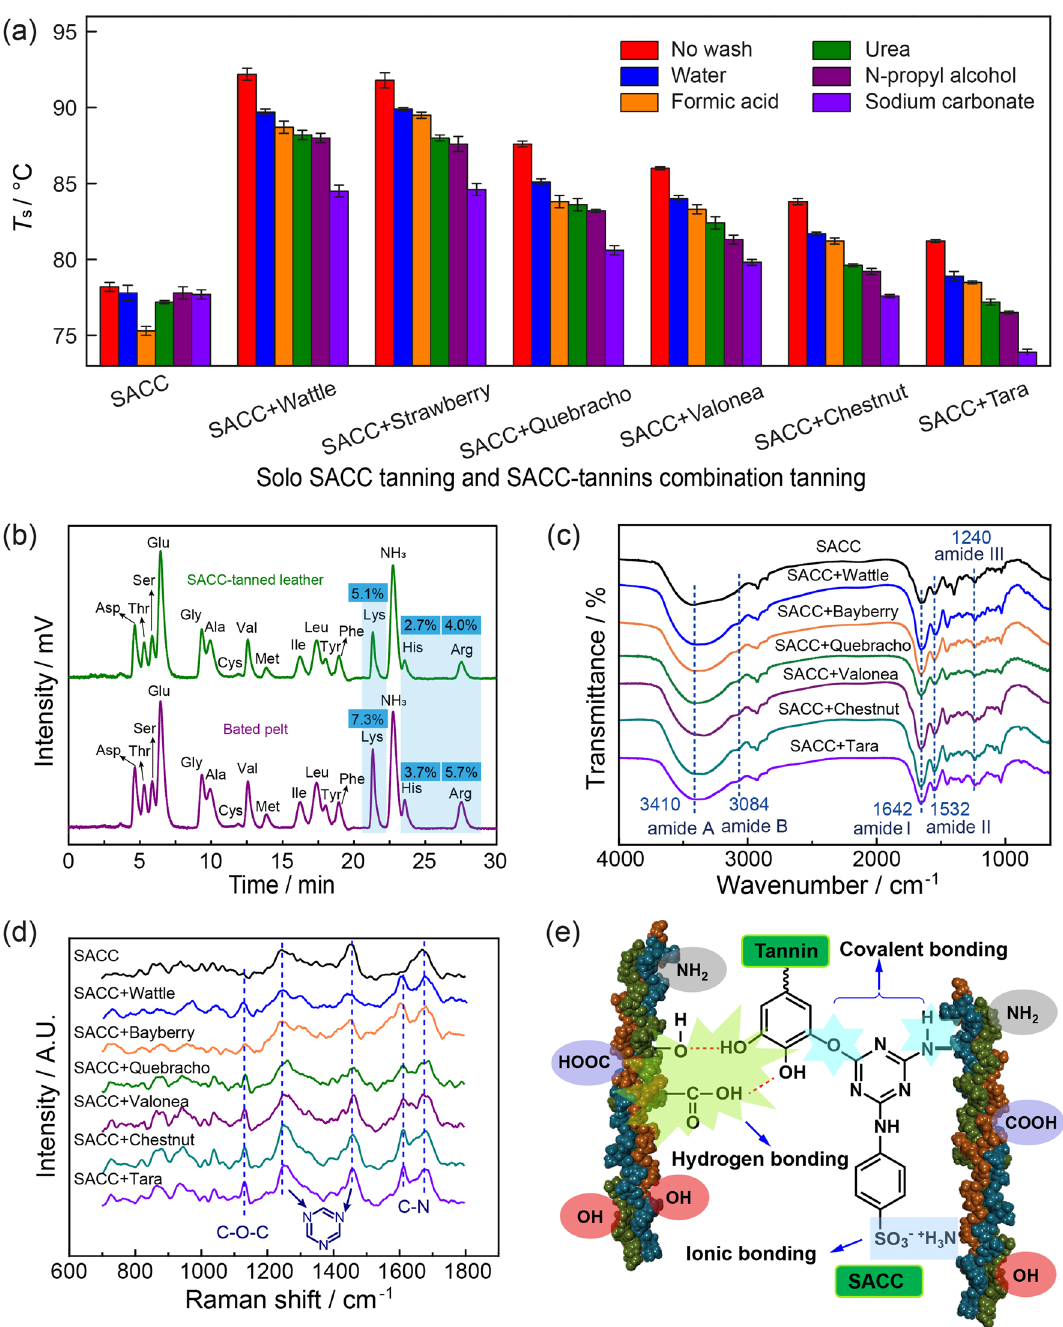
Fig. 3 a T s of produced leather after washing with different chemical media. b The chromatograms of amino acids in bated pelt and SACC-tanned leather. c FT-IR spectra and d Raman spectra of samples. e Schematic illustration showing synergistic interactions of SACC and tannins with collagen in the combination